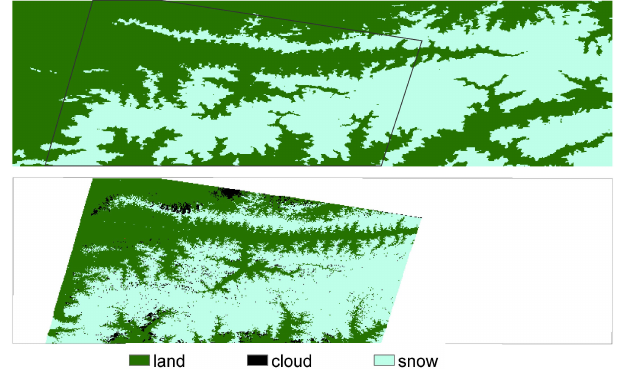
Figure 8. Reconstructed (top) and Landsat (bottom) snow-cover maps for 10 April 1998.